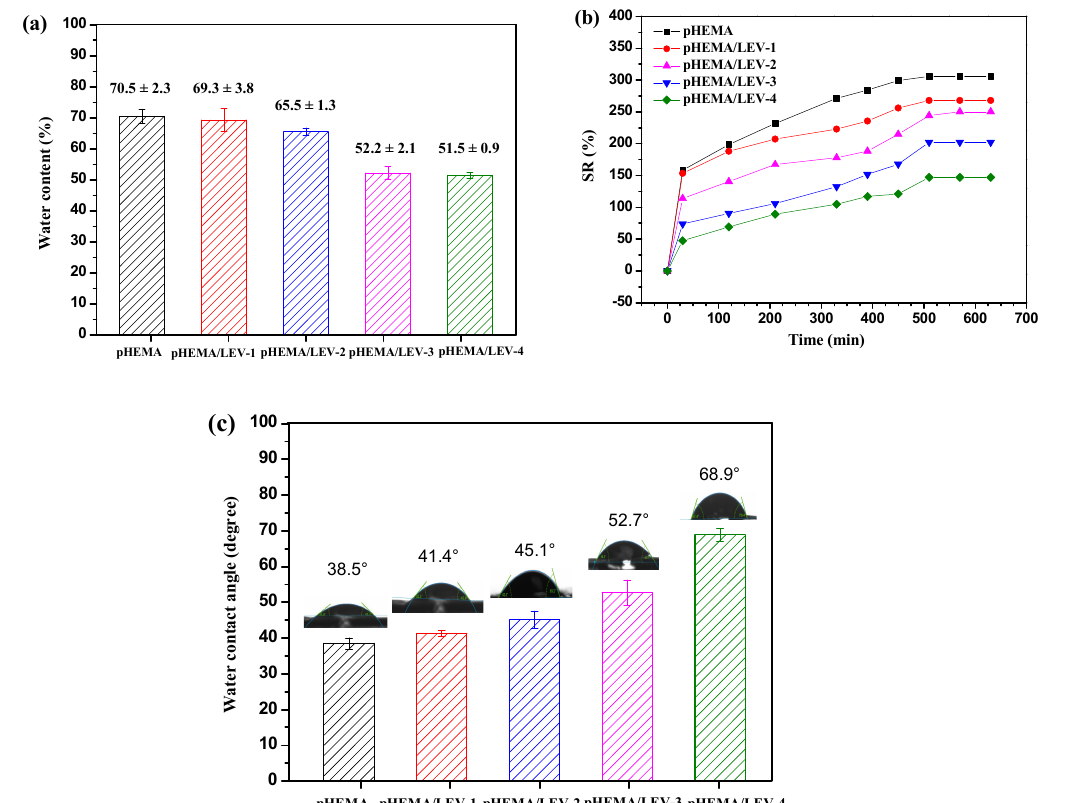
Figure 7. Water content after fully swelling in deionized water ( a ), water contact angle after droplet (5 μL) deposition on the surface of the series of contact lenses at room temperature ( n = 3) ( b ), and swelling kinetics of contact lenses in water at room temperature ( c ).